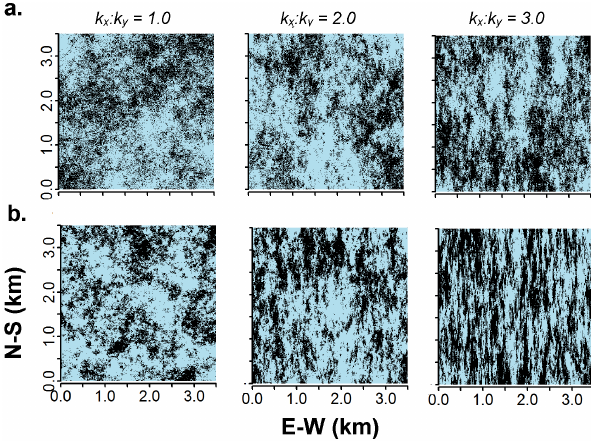
Figure 3. Simulated landscapes for various kx : ky ratios for (a) ky = 0 . 1 and (b) ky = 0 . 20. Note the increase in distinctiveness of ridge and slough patches with increasing magnitude of ky .